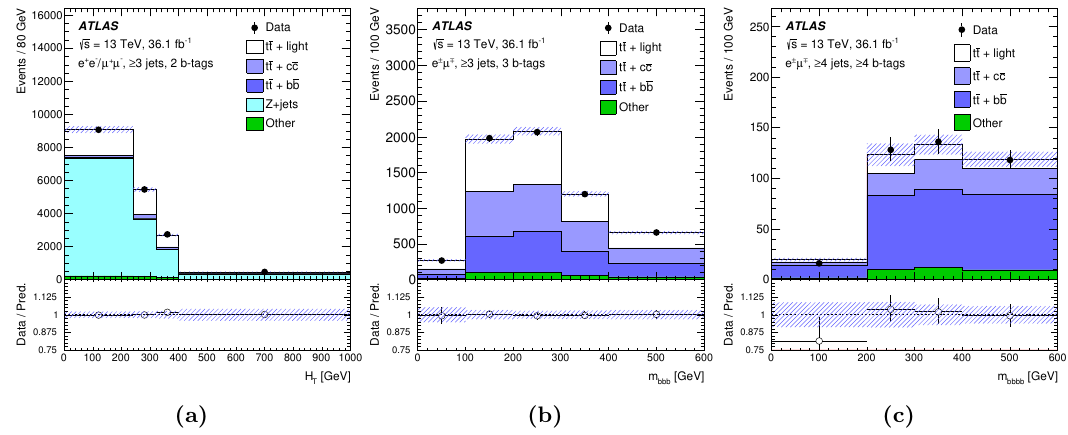
Figure 7. Comparison between data and prediction in the dilepton control regions of (a) the H T variable for same-(cid:13)avour dilepton events with (2 ‘ , 3j, 2b) and the invariant mass of b -tagged jets for di(cid:11)erent-(cid:13)avour dilepton events with (b) (2 ‘ , single-lepton and dilepton (cid:12)t to the data. The last bin contains the over(cid:13)ow.